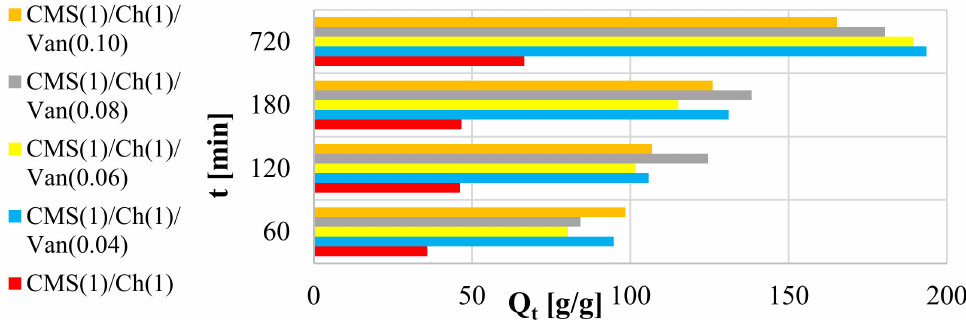
Figure 6. Swelling of the CMS(1)/Ch(1) polymer with a different amount of vanillin used in deionized